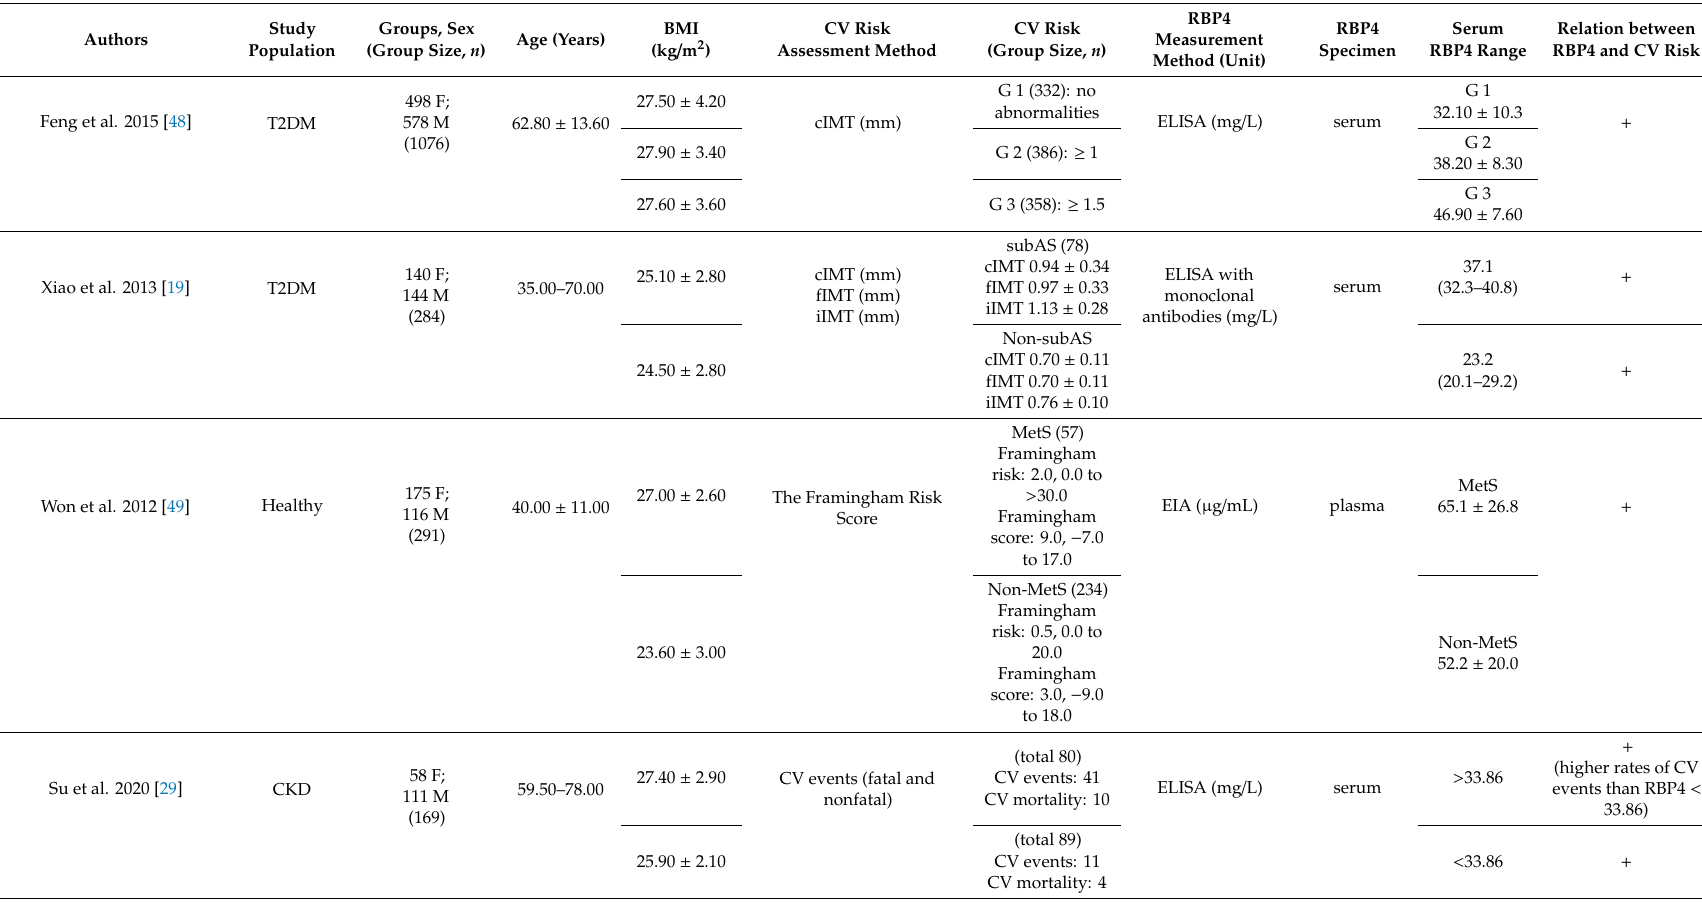
Table 1. The summary of measurement methods and serum retinol-binding protein 4 (RBP4) range in studies assessing cardiovascular (CV)